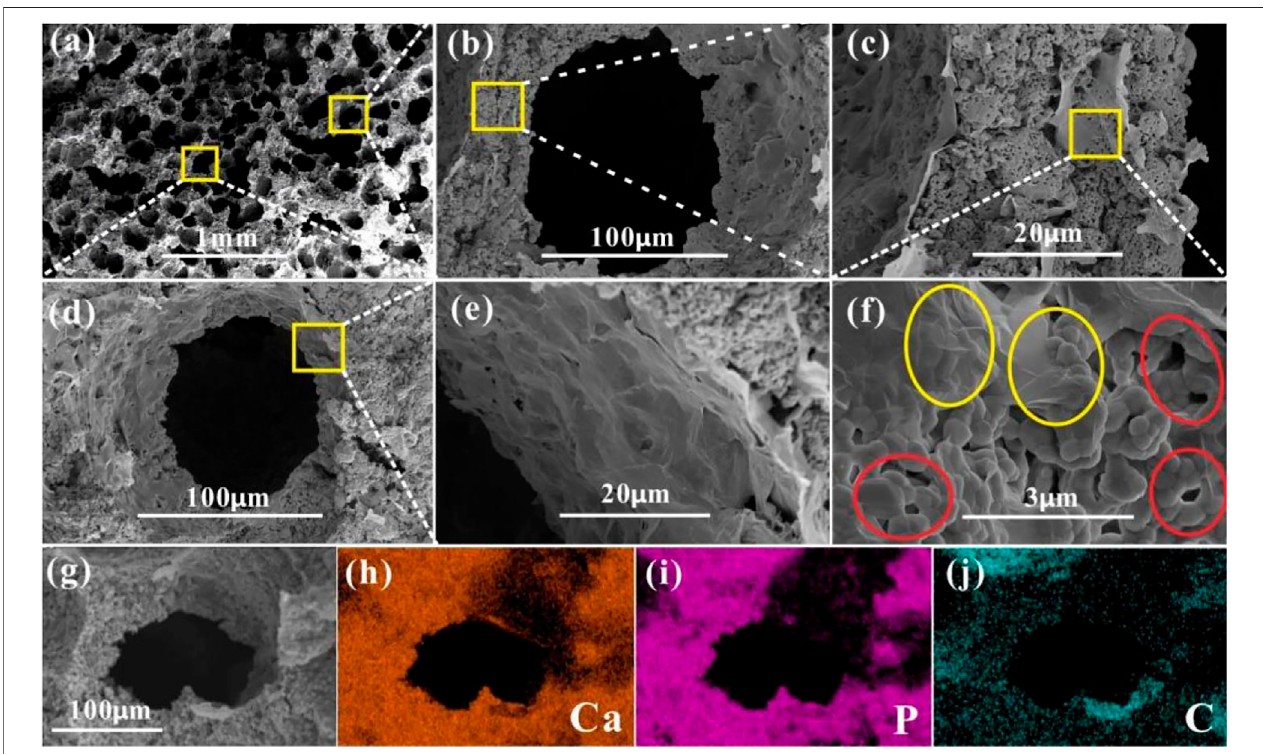
FIGURE 1 | SEM image of (A) the porous structure in HA/rGO-6/0.3 composite scaffold, and (B) (D) the pore structure, (C) cross-sectional structure of hole wall, (E) pore wall structure and (F) enlarged view of the cross-section of hole wall. (G) Pore structure of HA/rGO-6/0.3 and EDS (H) Ca, (I) P (J) C mapping images of Figure 2G . Reproduced from Zhou et al. (2019) with permission from Copyright 2019 American Chemical